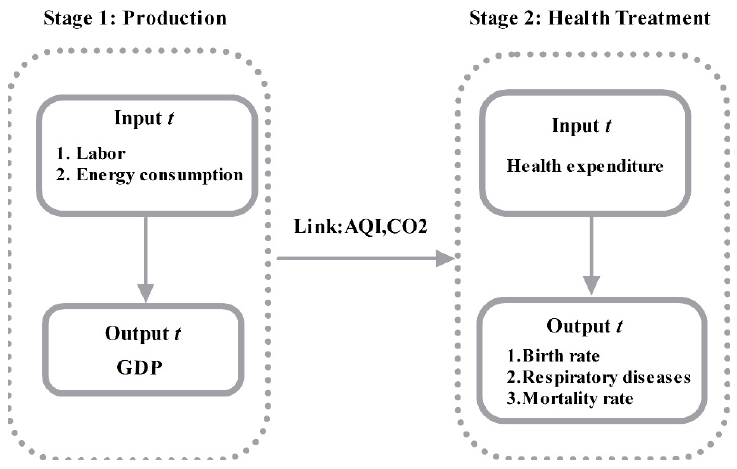
Figure 2. Modified undesirable EBM Two stage DEA.